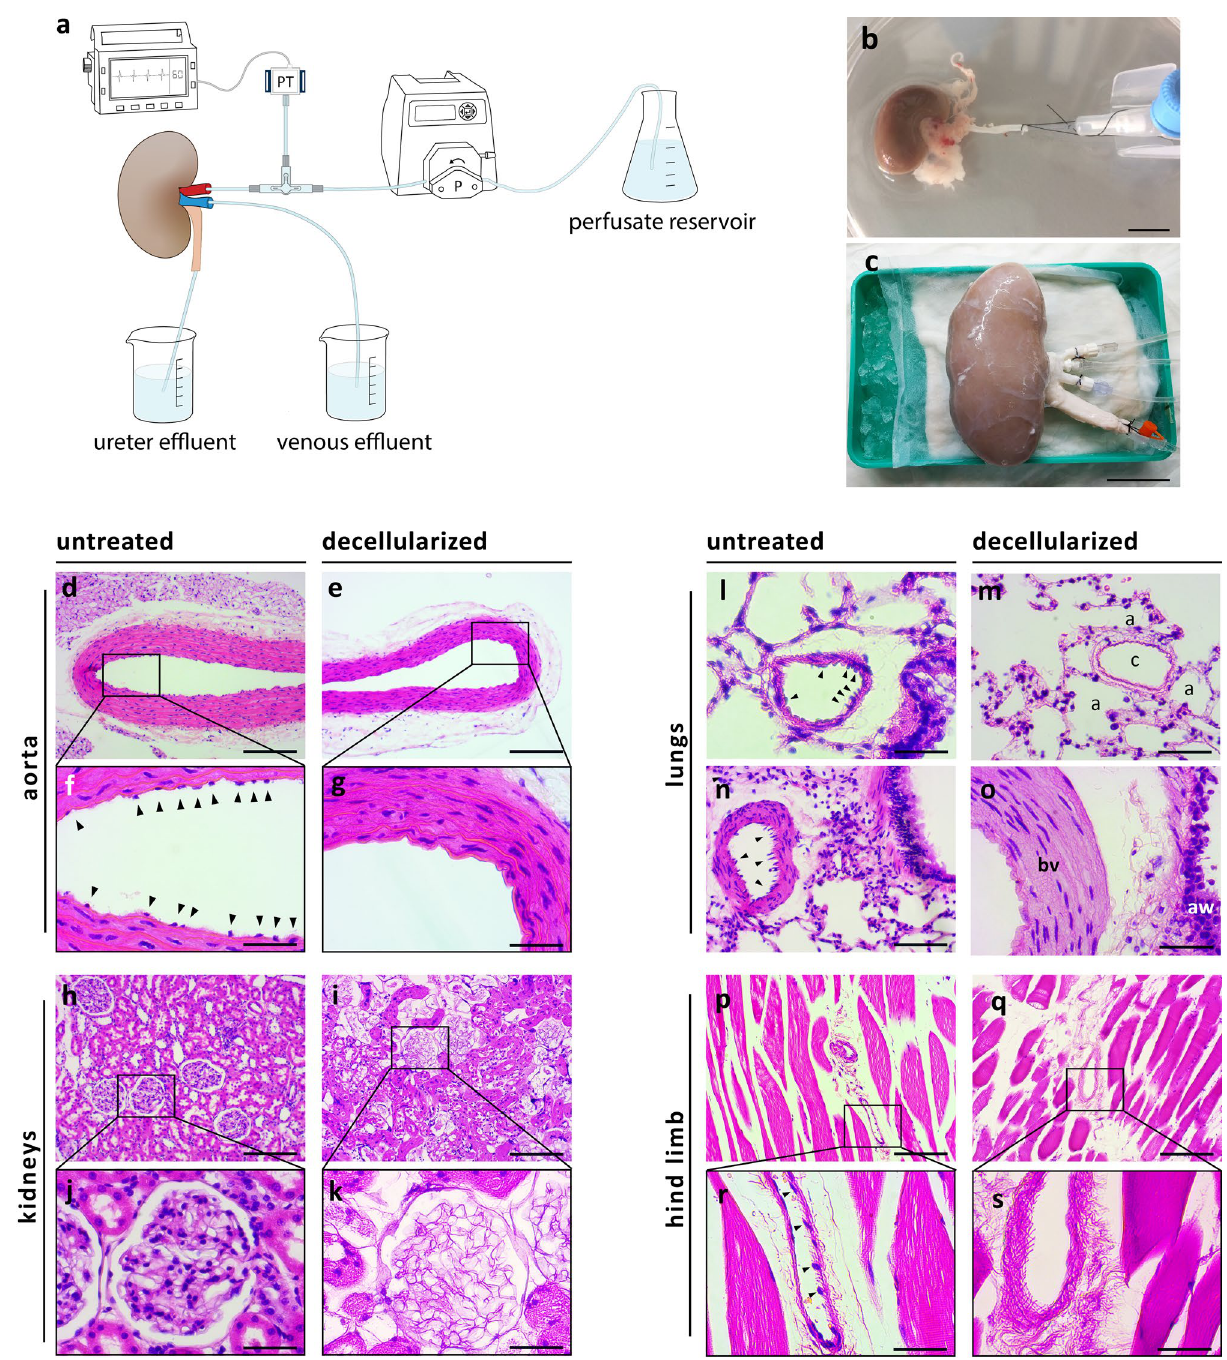
Figure 1. Ex vivo perfusion of rat and porcine organs and decellularization of the vascular tree. ( a ) Schematic representation of the hypothermic perfusion system used to decellularize rat and porcine organs. The circuit was driven by a peristaltic pump (Masterflex, Cole-Parmer) and controlled using a pressure transducer (Art-Line, Biometrix) and a monitor connected to the inflow cannula. (Illustration by Noa First Cohen). ( b , c ) Photographs of exemplary organs connected to the perfusion system: a rat kidney ( b ) cannulated using a 22G intravenous (IV) cannula placed in the abdominal aorta, and a porcine kidney ( c ) with Luer lock fittings placed into a single renal artery and two renal veins, and a 14G IV cannula placed into the ureter. Scale bars, 1 cm (B) and 5 cm (C). ( d – s ) Representative histological images of untreated and decellularized rat organs stained with hematoxylin and eosin (H&E): Low- and high-magnification of untreated aorta ( d , f ). Arrowheads show endothelial cells lining the luminal surface. Low- and high-magnification of decellularized aorta ( e , g ). Note the absence of the endothelial cell layer, while subendothelial tissue remains intact. Low- and high-magnification of untreated ( h , j ) and decellularized ( i , k ) rat kidneys. Note the appearance of acellular glomeruli with intact capillary wall structure, and preservation of epithelial cells of the surrounding collecting tubules. Representative images of untreated ( l , n ) and decellularized ( m , o ) lungs. Arrowheads show endothelial cells in untreated lung. Note the appearance of decellularized capillary surrounded by cellular alveoli ( m ) and de-endothelialized artery alongside cellular bronchiole ( o ). Low- and high-magnification of untreated ( p , r ) and decellularized ( q , s ) hind limb. Arrowheads show endothelial cells in untreated hind limb. PT, pressure transducer; P, pump; c, capillary; a, alveolus; bv, blood vessel; aw, airway. Scale bars, 50 µm ( f , g , j , k , l , o , r , s ), 100 µm ( m , n ) and 200 µm ( d , e , h , i , p , q